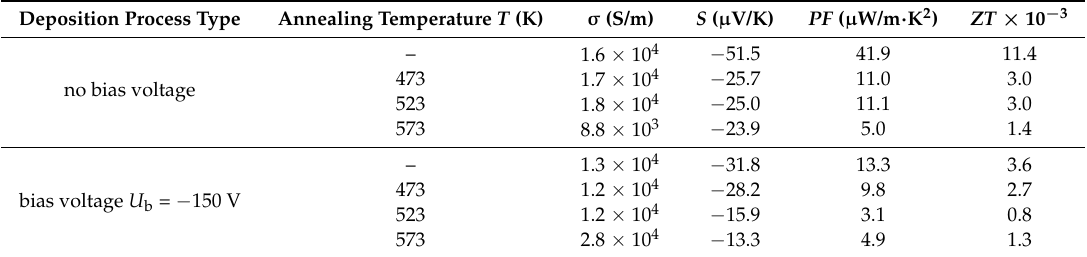
Figure 9. The dimensionless figure of merit ZT as a function of the structure’s temperature T before and after annealing: ( a ) Ge–Au/NiCrSi/Ag test structures deposited in the sputtering process without external bias voltage; ( b ) Ge–Au/NiCrSi/Ag test structures deposited in the sputtering process with external bias voltage. Table 2. Electric and thermoelectric properties of the Ge–Au/NiCrSi/Ag test structures at 300 K: conductivity σ , Seebeck coefficient S , power factor PF, and ZT .